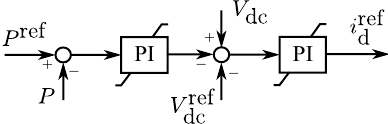
Figure 2. Diode-rectifier (DR)-HVDC link power and voltage controls used in VSC1.